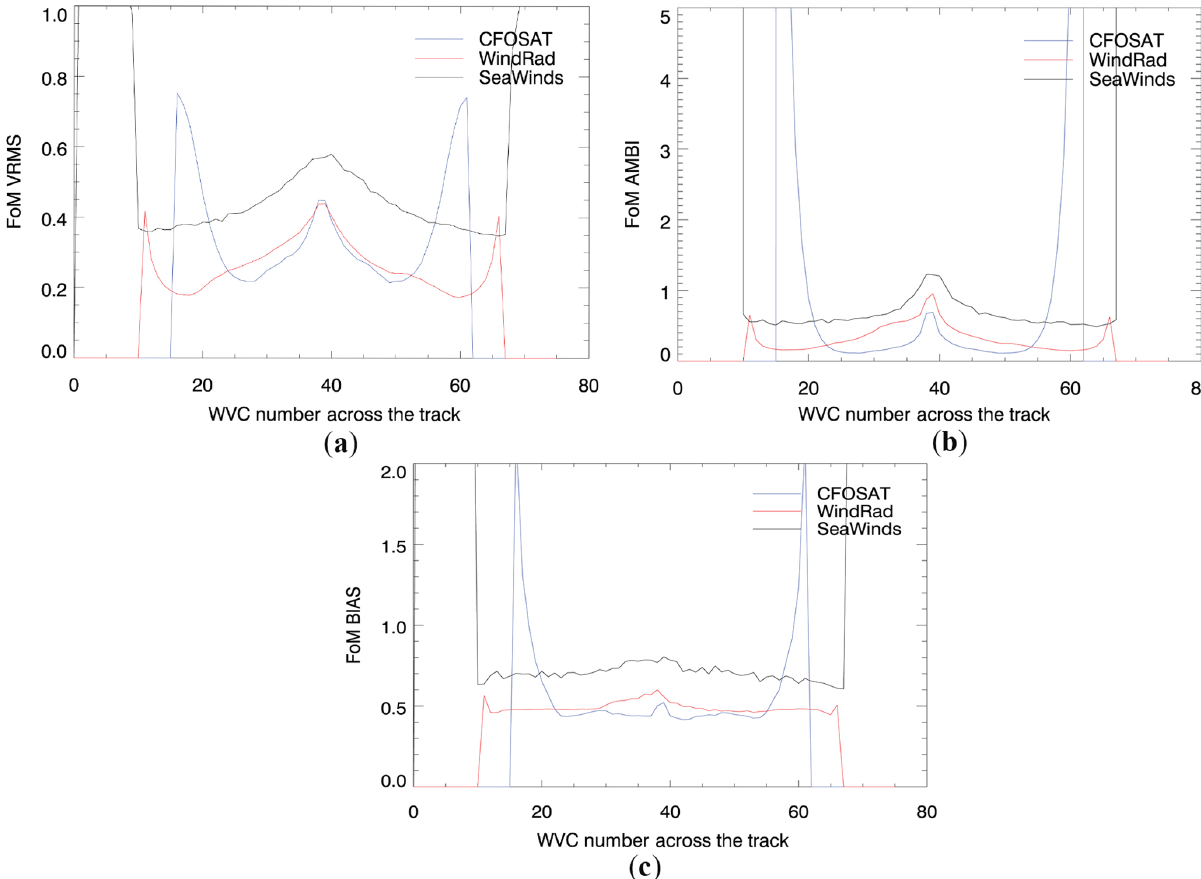
Figure 20. FoM results of SCAT, WindRad, and SeaWinds. (a) VRMS comparison. (b) AMBI comparison. (c) BIAS